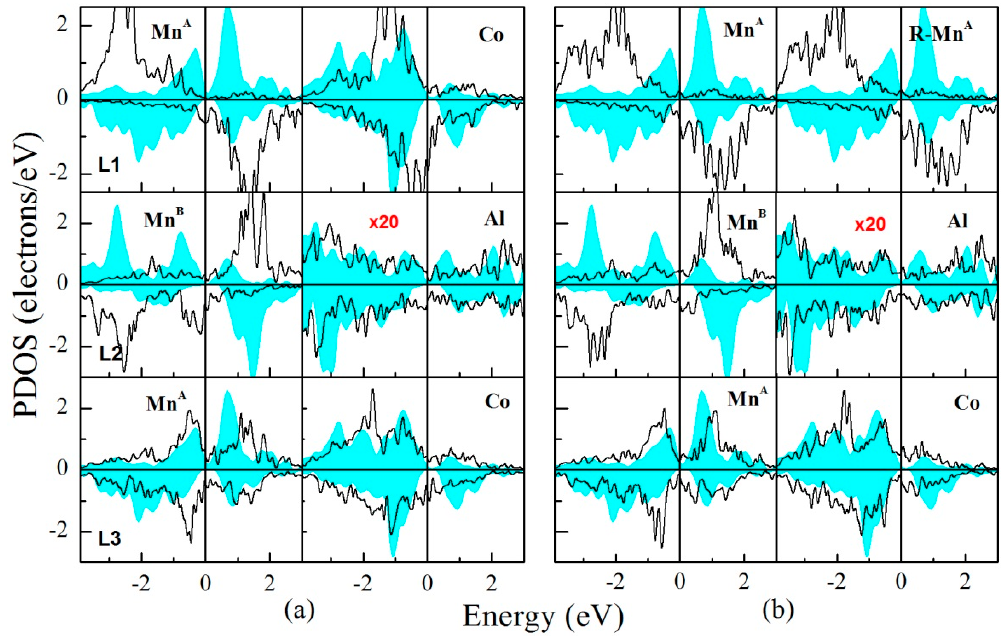
Figure 7. The partial density of states (PDOS) of ( a ) MnCo T - and ( b ) MnMn T1 -terminated structures. The shadow region indicates atomic PDOS of the bulk. L1, L2, and L3 indicate the interface, subinterface, and next subinterface, respectively.